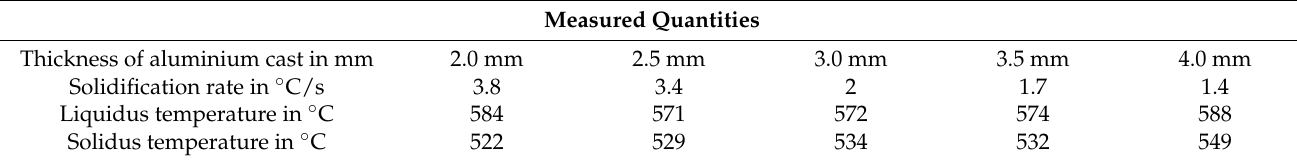
Table 3. Solidification rate depending on the cast plate thickness of